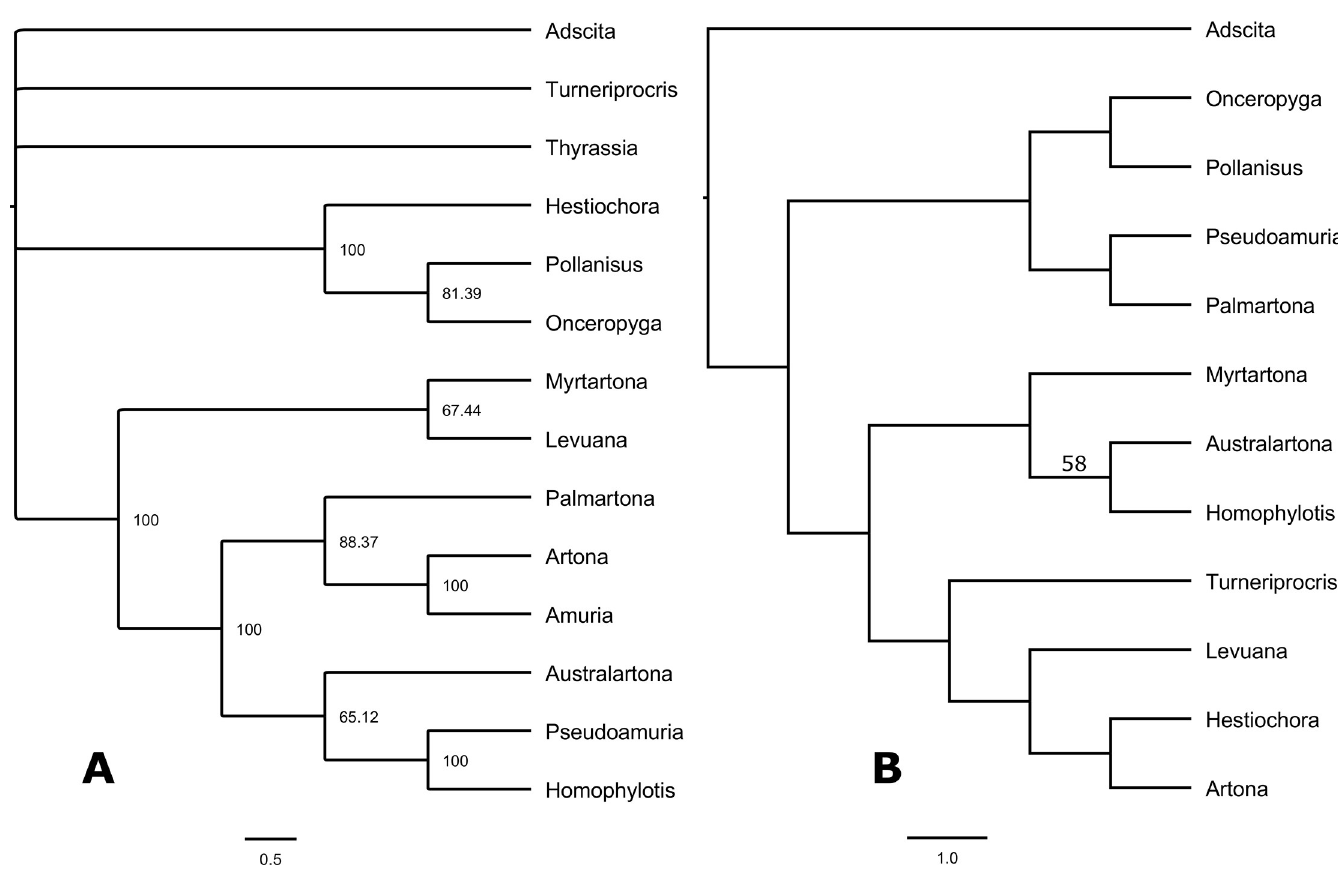
Fig 2. A) Tree from Branch-and-Bound analysis of morphological characters alone in PAUP. Node values indicate 50% majority rule consensus of 43 equally parsimonious trees. B) Tree from Maximum Likelihood analysis of DNA barcodes in PAUP. Only one node ( Australartona + Homophylotis ) has bootstrap support of over